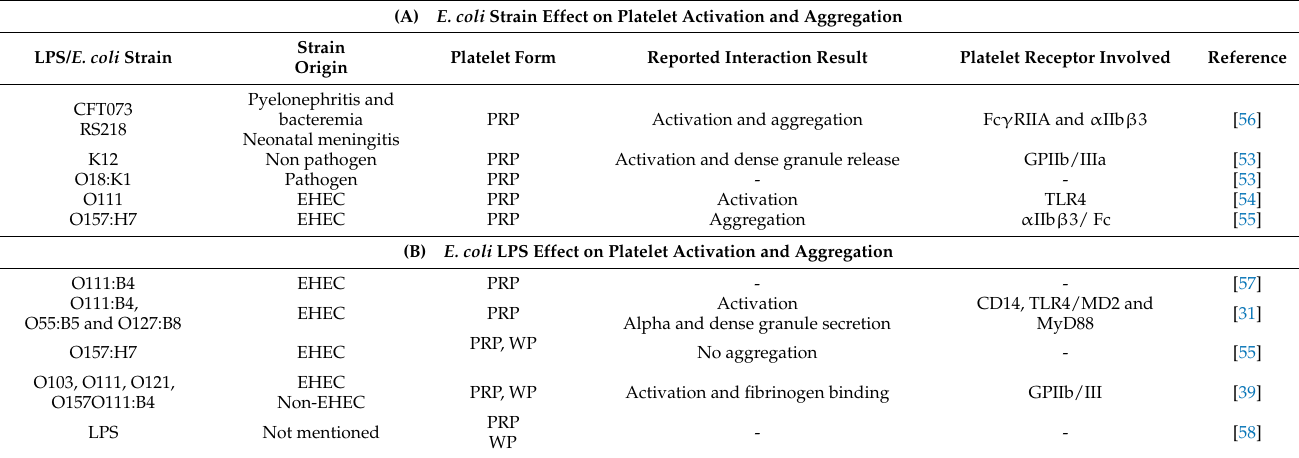
Table 1. Summary of E. coli strains and E. coli pure LPS effect on platelets. (A) E. coli Strain Effect on Platelet Activation and Aggregation